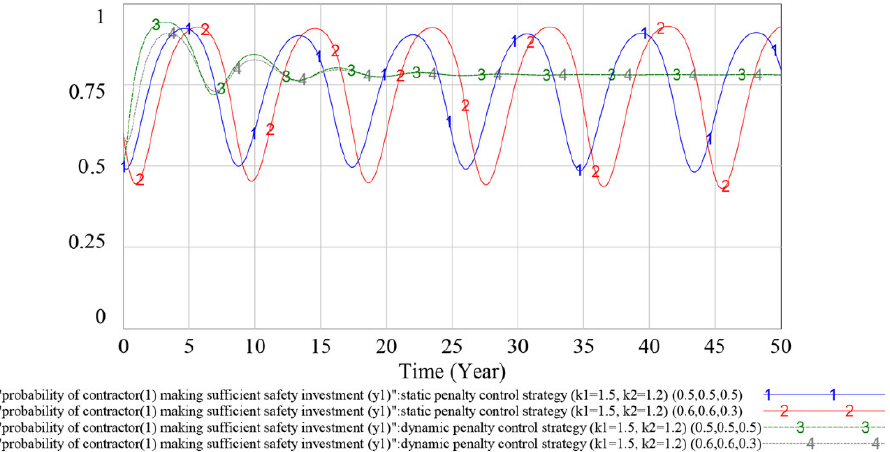
Figure 11. Influence of different initial values on contractor (1)’s strategy choices under different penalty control strategies.